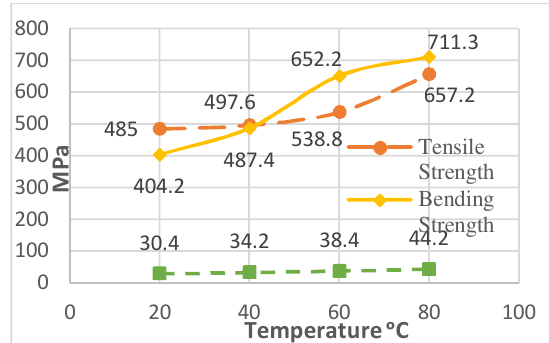
Fig 6: Variation of Mechanical Properties with Varying